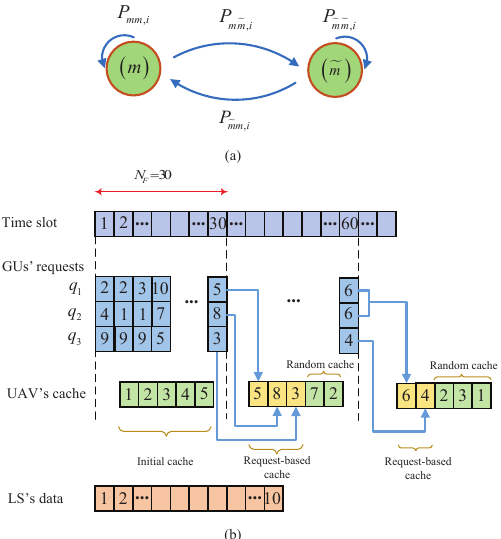
Figure 2. ( a ) The request model of GU i . ( b ) An example of caching and serving procedures by the UAV, where N F = 30, C F = 5, I = 3, and K =